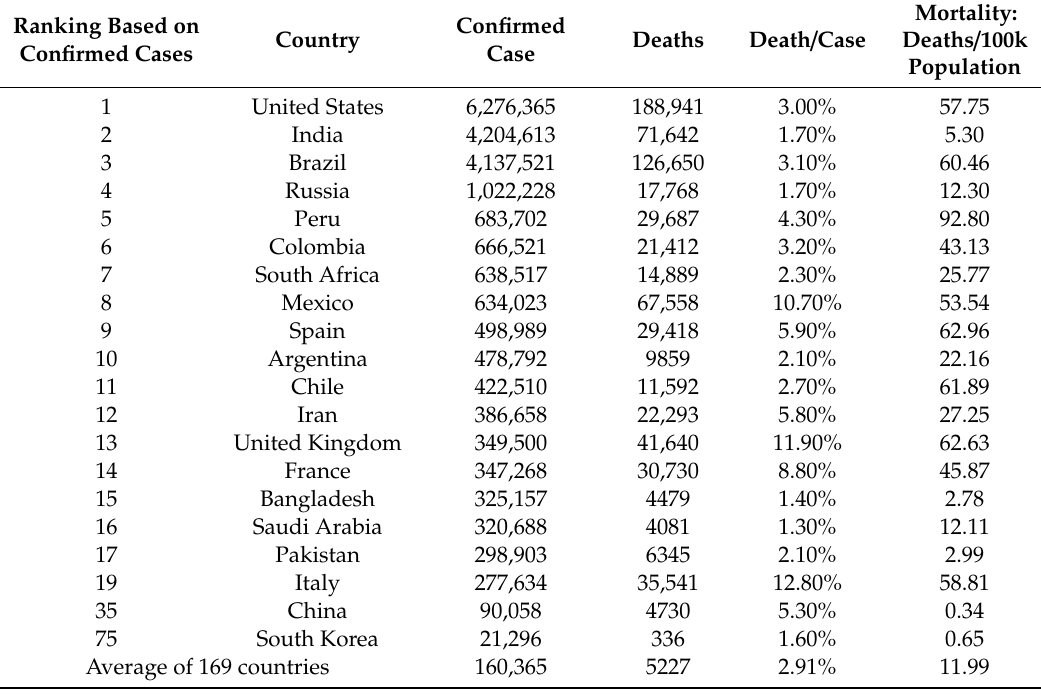
Figure 1. Mortality rates in the most affected countries. Source [45]. Table 2. A summary of COVID-19 statistics for selected countries (7 September